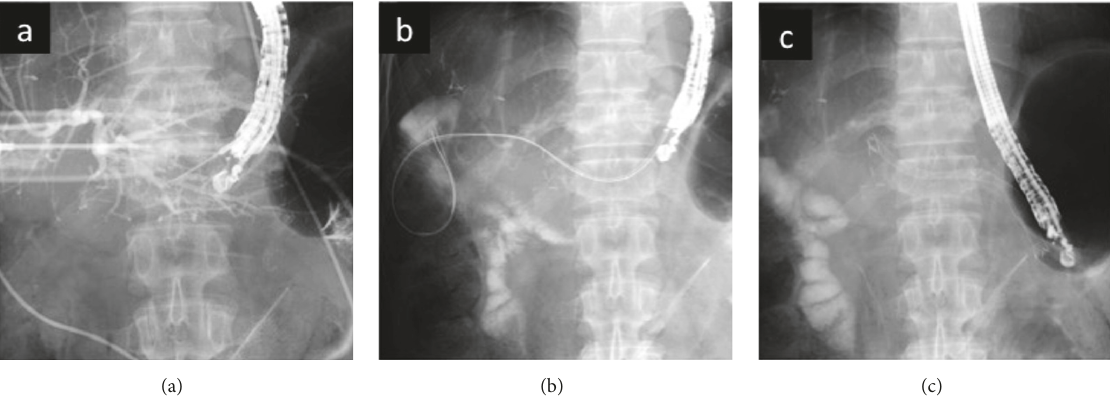
Figure 1: Endoscopic ultrasound-guided hepaticogastrostomy (EUS-HGS). (a) Bile duct is punctured with a 19-G needle. (b) Guidewire is inserted into the bile duct. (c) Metallic stent is placed.